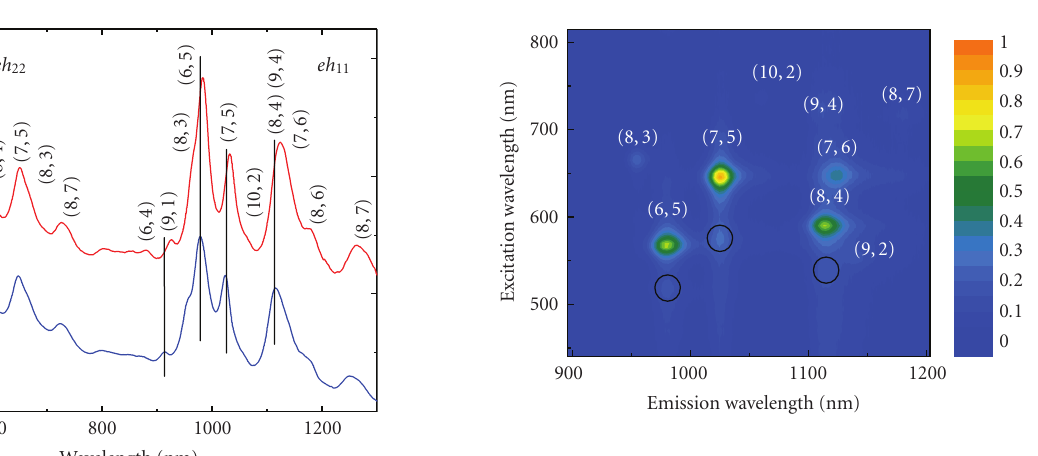
Figure 5: PLE map for SDBS-encapsulated CoMOCAT SWNT dispersion. Each ( eh 22 , eh 11 ) resonance is labeled with the chiral index of the corresponding SWNT. Open circles indicate the positions of phonon sidebands eh ph 22 of SWNTs. Broad and elongated spectral features are assigned to EET between